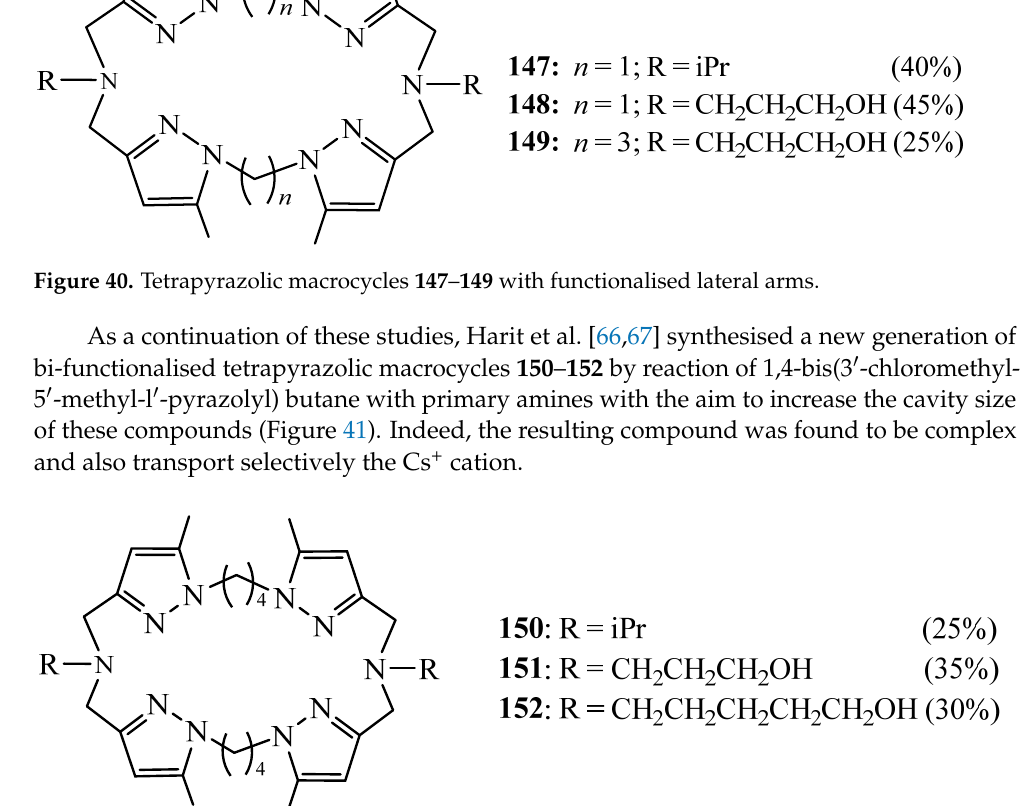
Figure 40. Tetrapyrazolic macrocycles 174 − 176 with functionalised lateral arms.